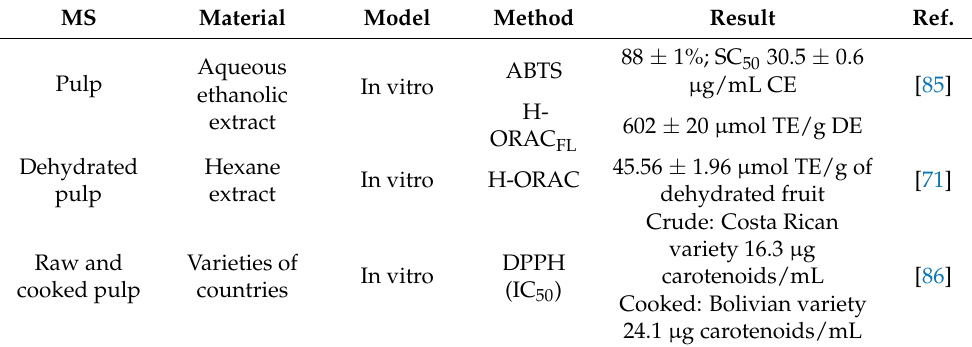
Table 6. Antioxidant activity of B. gasipaes .